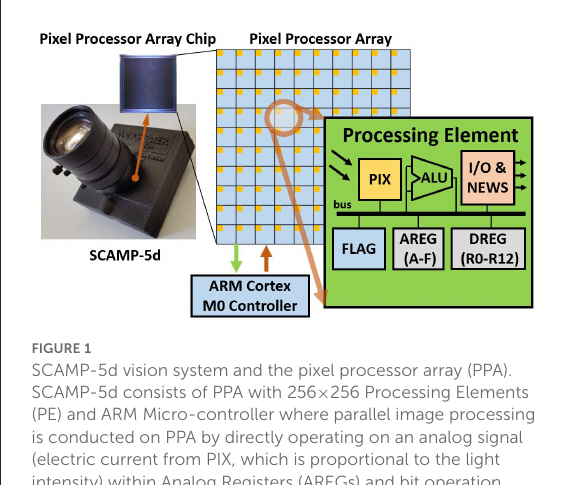
FIGURE1 SCAMP-5d vision system and the pixel processor array (PPA). SCAMP-5d consists of PPA with 256 × 256 Processing Elements (PE) and ARM Micro-controller where parallel image processing is conducted on PPA by directly operating on an analog signal (electric current from PIX, which is proportional to the light intensity) within Analog Registers (AREGs) and bit operation within Digital Registers